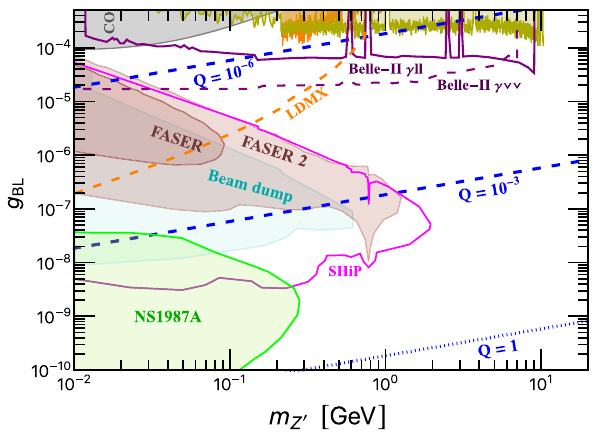
Fig. 3 Same as Fig. 2 but for freeze-in mechanism. The diagonal blue lines from top to bottom indicate Q = 1 , 10 − 3 , 10 − 6 ,